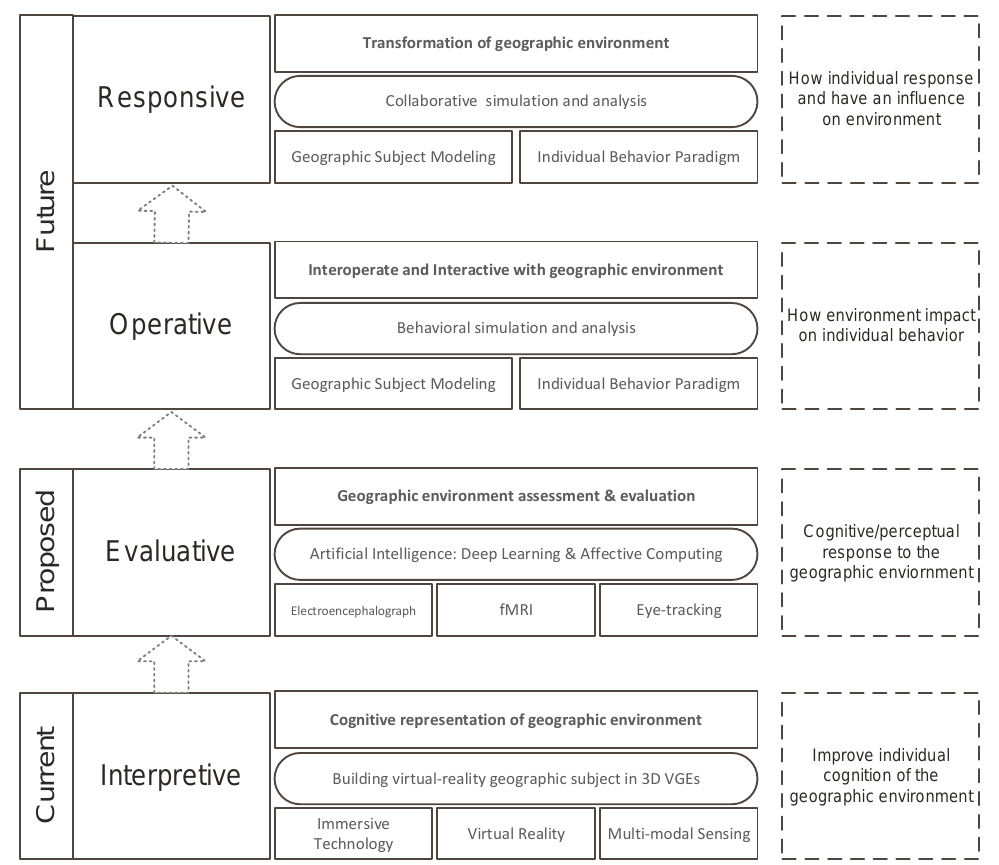
Figure 2. Framework of virtual cognitive experiments in